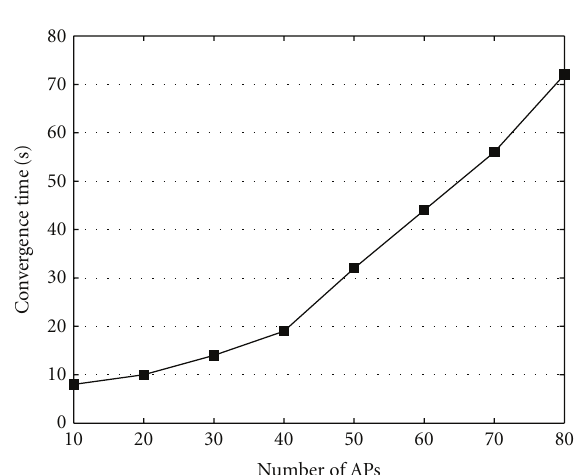
Figure 14: Propagation e ff ect when the AP that “fires” the execution of LAC is placed at the center of the